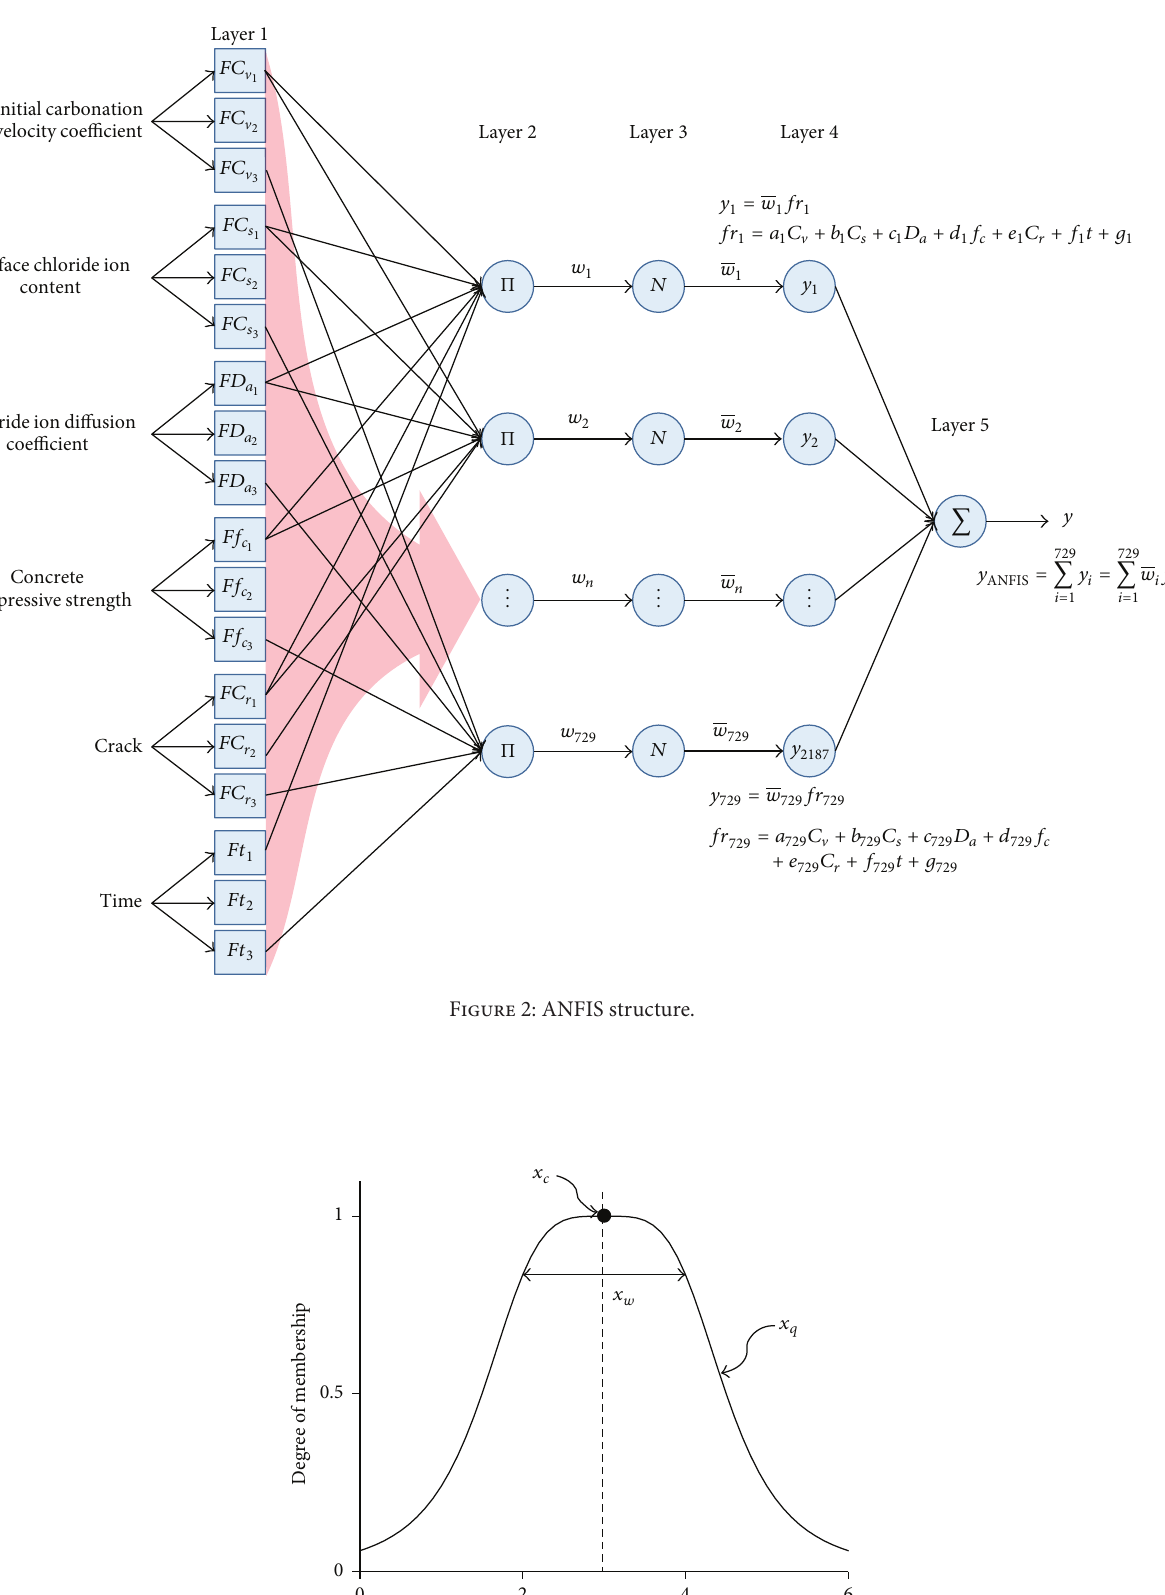
Figure 2: ANFIS structure.